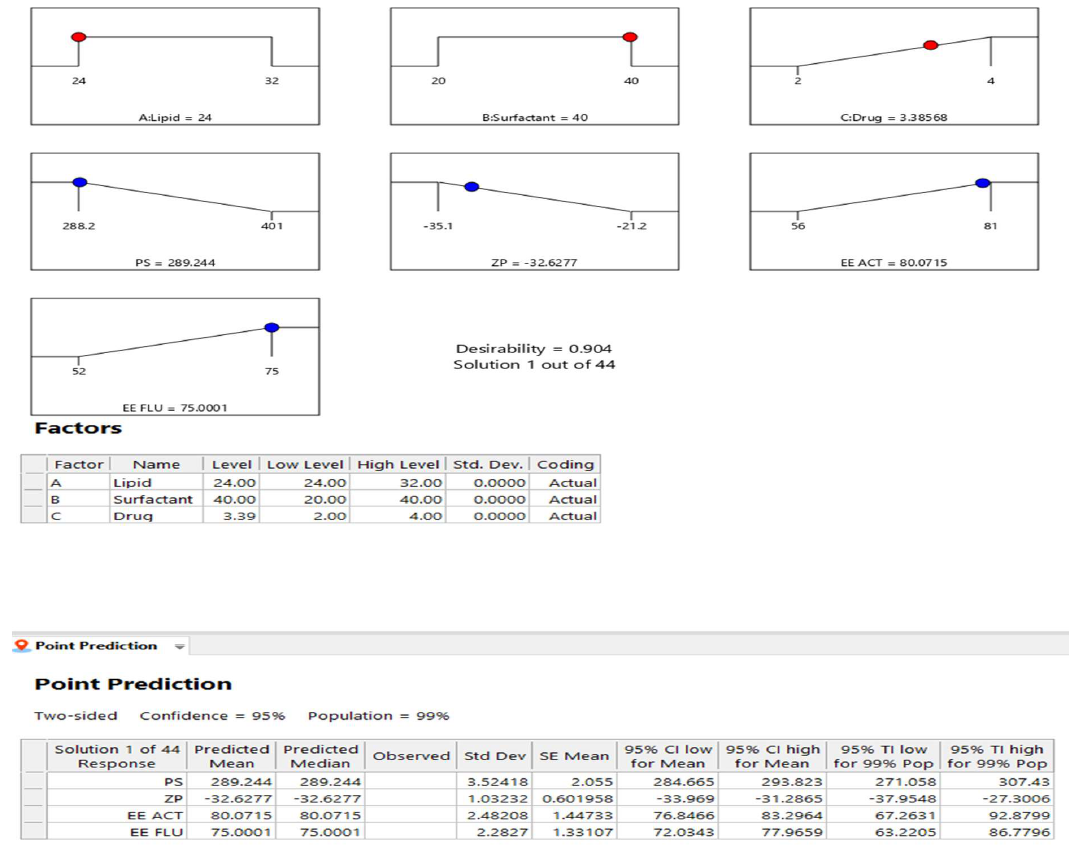
Figure 1. Desirability and point prediction data provided by Design Expert ® for the selection of the optimized